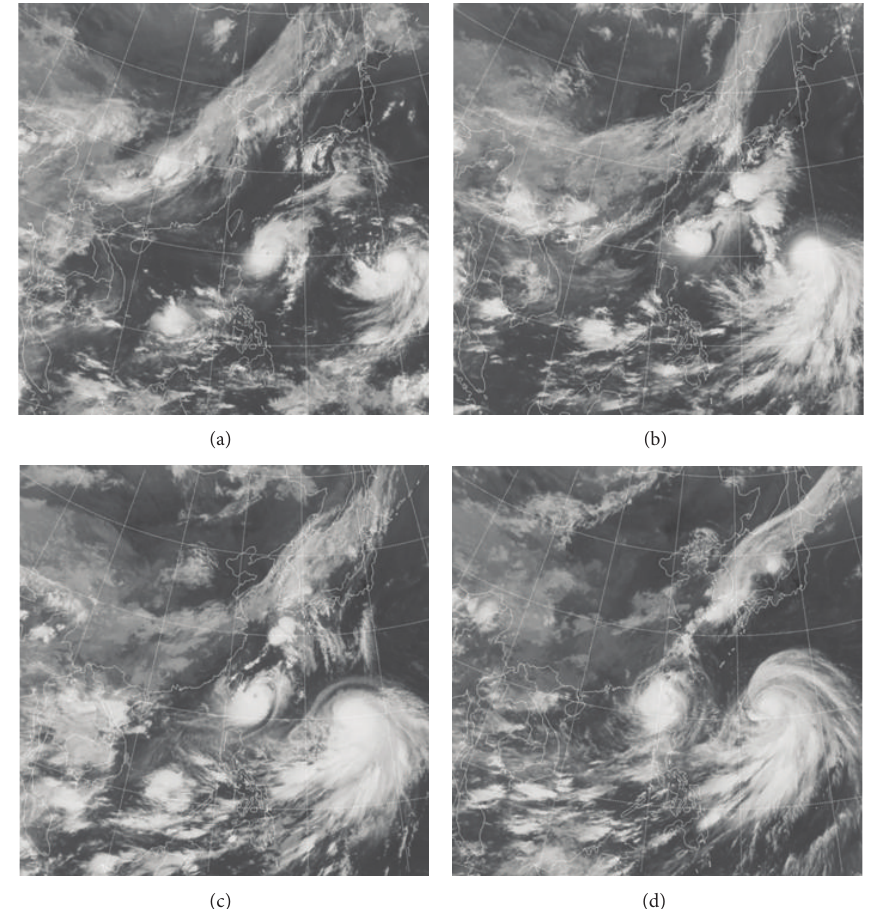
Figure 5: IR1 LCC images at (a) UTC 8 :32 on 21 August, (b) UTC 8 :32 on 22 August, (c) UTC 8 :32 on 23 August, and (d) UTC 8 :32 on 24 August, derived from CWB of